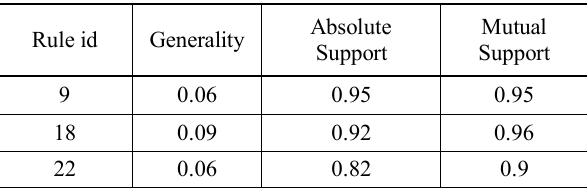
Table 3. Quality measurements of the extracted rules